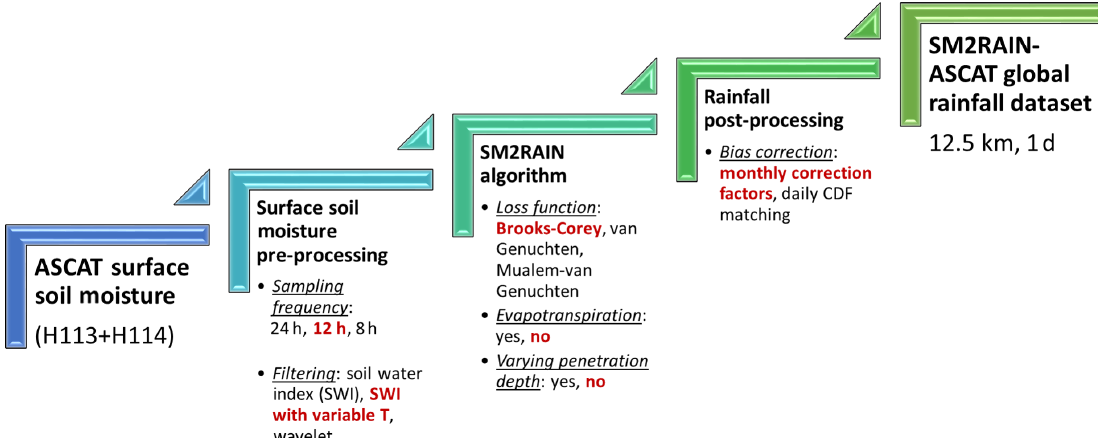
Figure 1. Processing steps for obtaining the SM2RAIN–ASCAT global rainfall data record (2007–2018) from ASCAT surface soil moisture data: pre-processing, SM2RAIN algorithm, and post-processing. Each bullet represents a possible configuration that has been tested; the selected configuration is in a red, bold font. Table 2. Configurations used in the paper (SWI – soil water index, BCO – Brooks–Corey, VGEN – van Genuchten, MUA – Mualem– van Genuchten, SWI-Tvar – SWI with T varying with soil moisture, WAV – wavelet filtering, CDF – climatological correction with daily cumulative density function matching, and MON – climatological correction with monthly correction